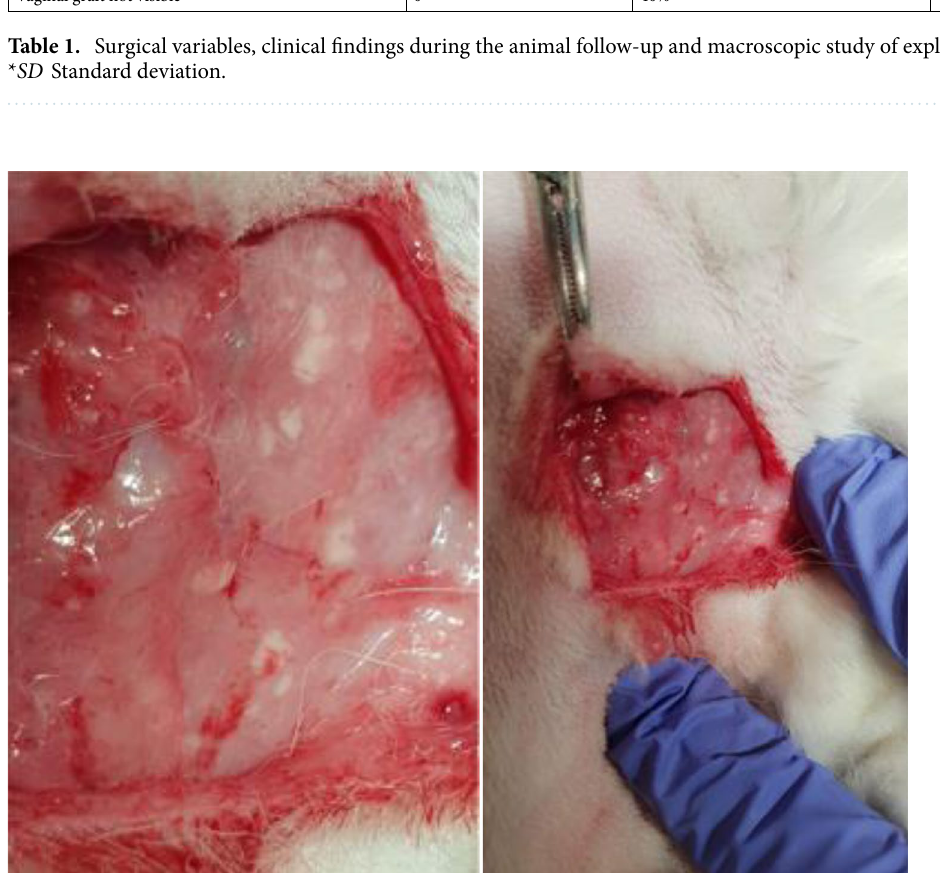
Figure 2. Multiple purulent collections arranged around the mesh, during explant removal